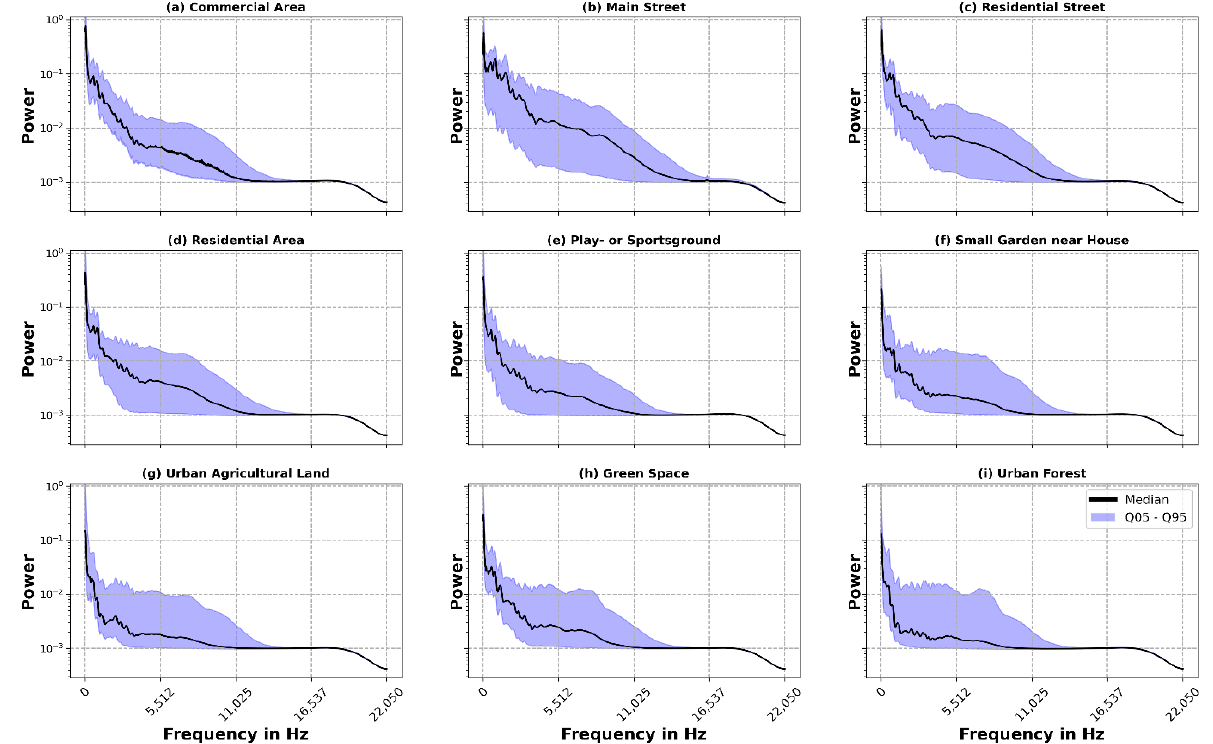
Figure 3. Log-scale frequency spectrum for all recordings, grouped by land use type ( a – i ). The black line represents the median of all recordings, and the blue area the range between the 5% and 95% quantile.